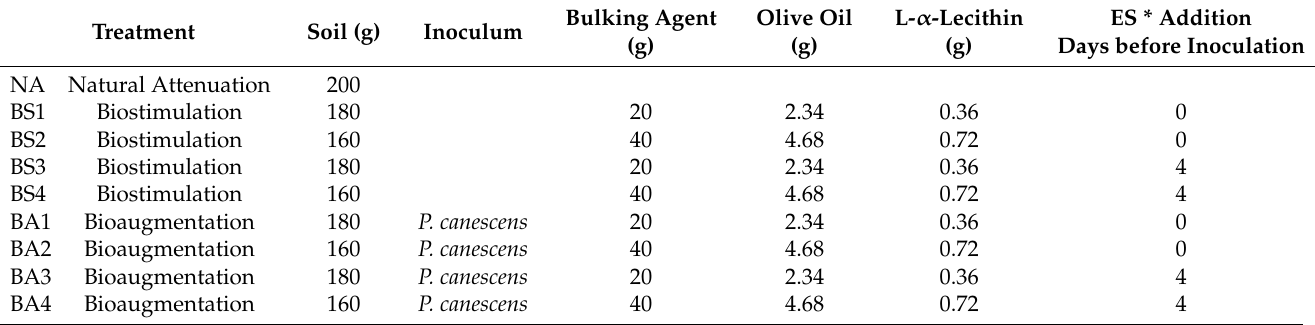
Table 1. Experimental design and